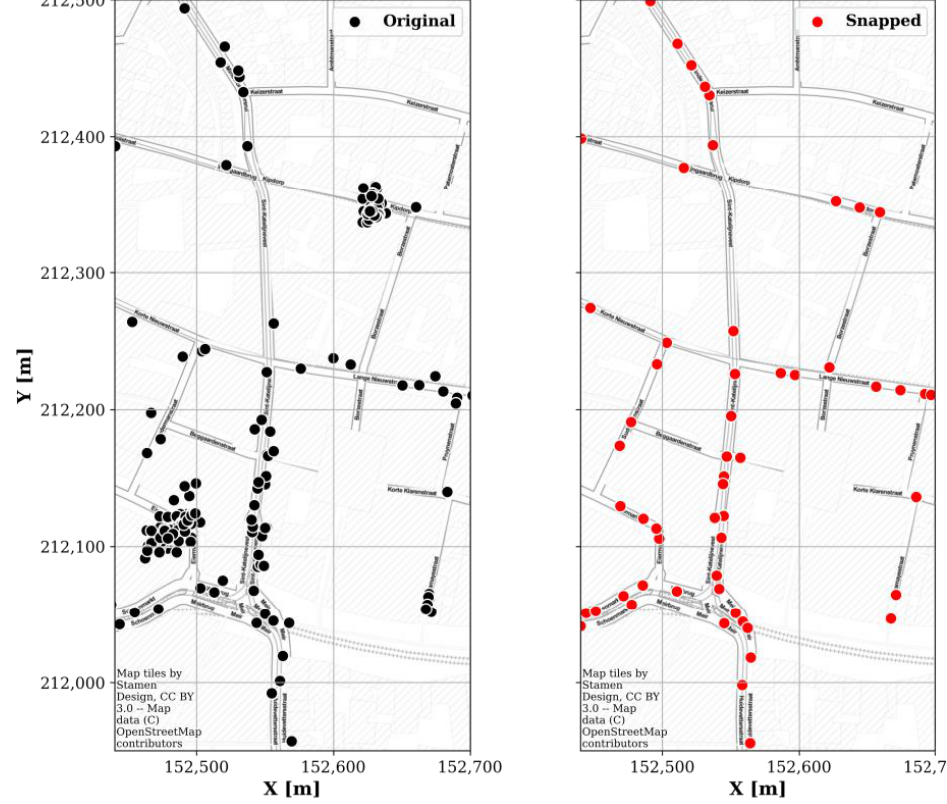
Figure 4. Original GPS coordinates of mobile sensor samples ( left ) and processed ‘snapped’ coordinates ( right ) [16] (coordinate system: Belgian Lambert 1972).